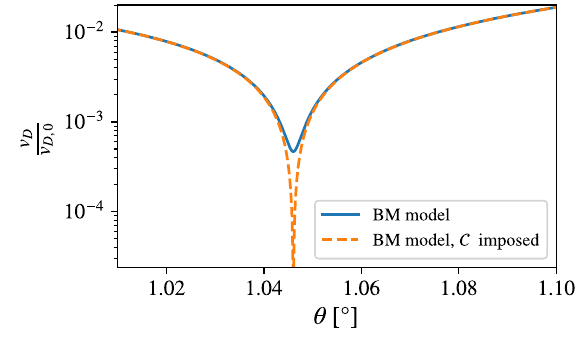
FIG. 2. The Dirac velocity v of the BM model [Eq. (B1)], with D and without the additional C symmetry, as the twist angle θ is varied near the magic angle. The C symmetry is imposed by setting θ ¼ 0 in the h ð θ Þ